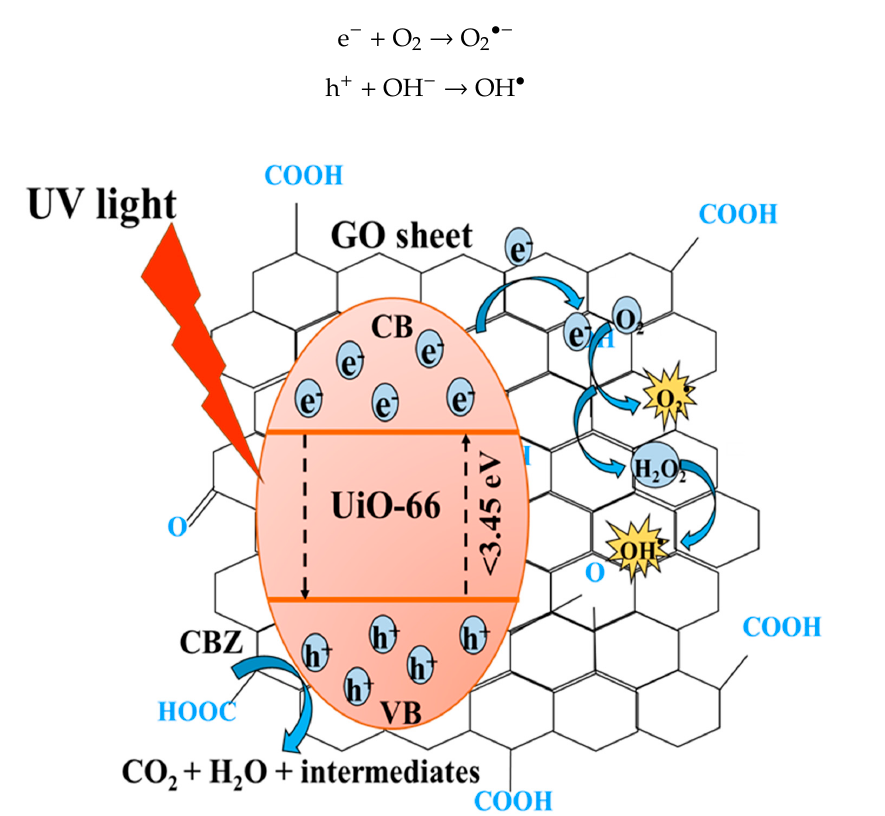
Figure 8. Schematic diagram of the proposed mechanism for the enhanced photocatalytic oxidation over the UiO-66_GO composite catalyst.